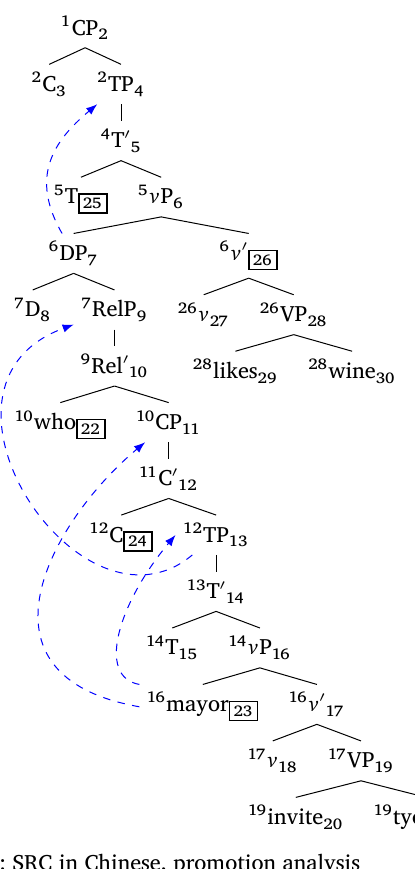
Figure 11: SRC in Chinese, promotion